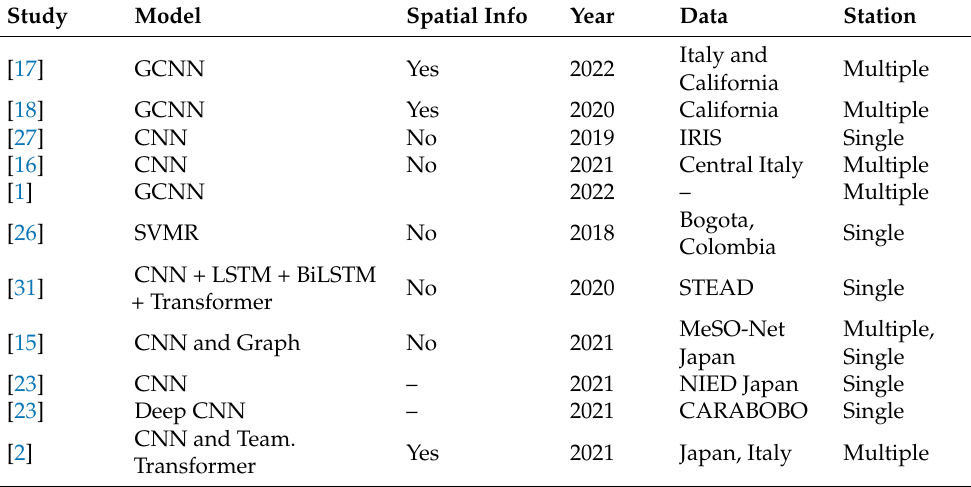
Table 1. A summary of the literature is discussed in this study. Most of the studies do not use spatial information about